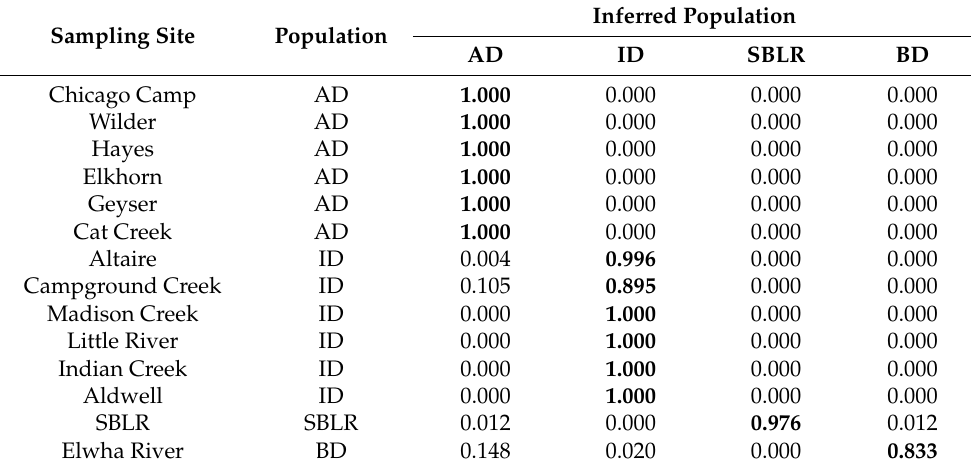
Table 2. Simulations performed on all 479 individuals included in the reference sampling sites reflected high accuracy of assignment on average across individuals from each sampling site back to their respective population (AD = above the dams, ID = in between the dams, SBLR = South Branch of the Little River, and BD = below the dams). The posterior likelihoods for population assignment displayed below reflect the mean of the scaled likelihoods of assignment of individuals to an inferred population based on sampling site. The scaled likelihood of individual assignment is calculated by taking the sum of the likelihoods of assigning a fish back to their inferred sampling site. Bolded values indicate the highest mean posterior likelihood for inferred population